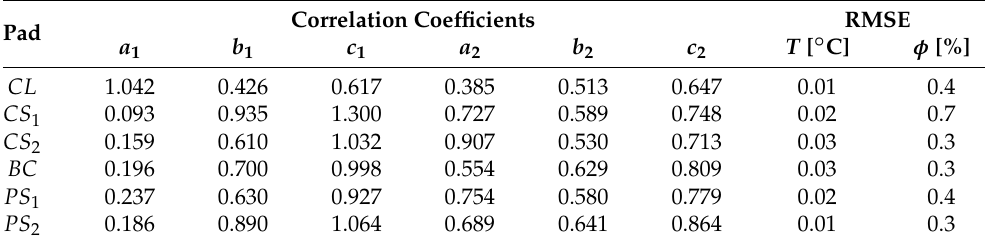
Table 8. Coefficients of correlation (3) used to compute the convective heat and mass transfer coefficients.